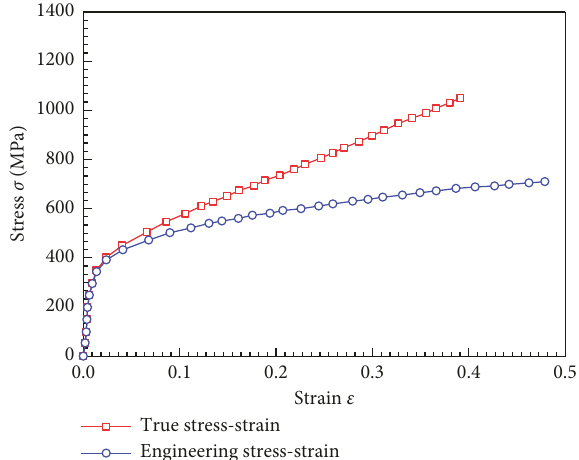
Figure 6: Stress-strain data of 306 stainless